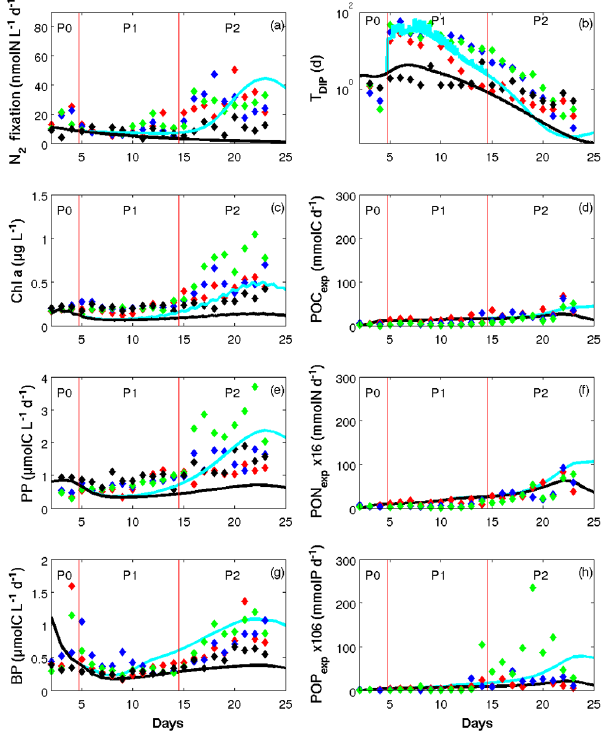
Figure 4. Patterns of change over time in (a) dinitrogen fixation (N 2 fixation) rates (nmolNL − 1 d − 1 ), (b) dissolved inorganic phos- phate turnover time ( T DIP , days), (c) chlorophyll a (Chl a , µgL − 1 ), (d) particulate organic C exported (POC exp , dry matter in mmolC), (e) primary production (PP) rates (µmolCL − 1 d − 1 ), (f) particulate organic nitrogen exported × 16 (PON exp , dry matter in mmolN), (g) bacterial production (BP) rates (µmolCL − 1 d − 1 ) and (h) par- ticulate organic phosphate exported × 106 (POP exp , dry matter in mmolN) in model outputs (solid lines: SIM E – blue; SIM C – black) averaged over depth superimposed on data observations av- eraged over depth in the three mesocosms (M1, red; M2, blue; M3, green) and in surrounding waters (black). Red vertical lines distin- guish the three periods P0 (before the DIP enrichment), P1 (diatom– diazotroph associations dominate the diazotrophic community) and P2 (unicellular N 2 -fixing cyanobacteria (Group C) dominate the di- azotrophic